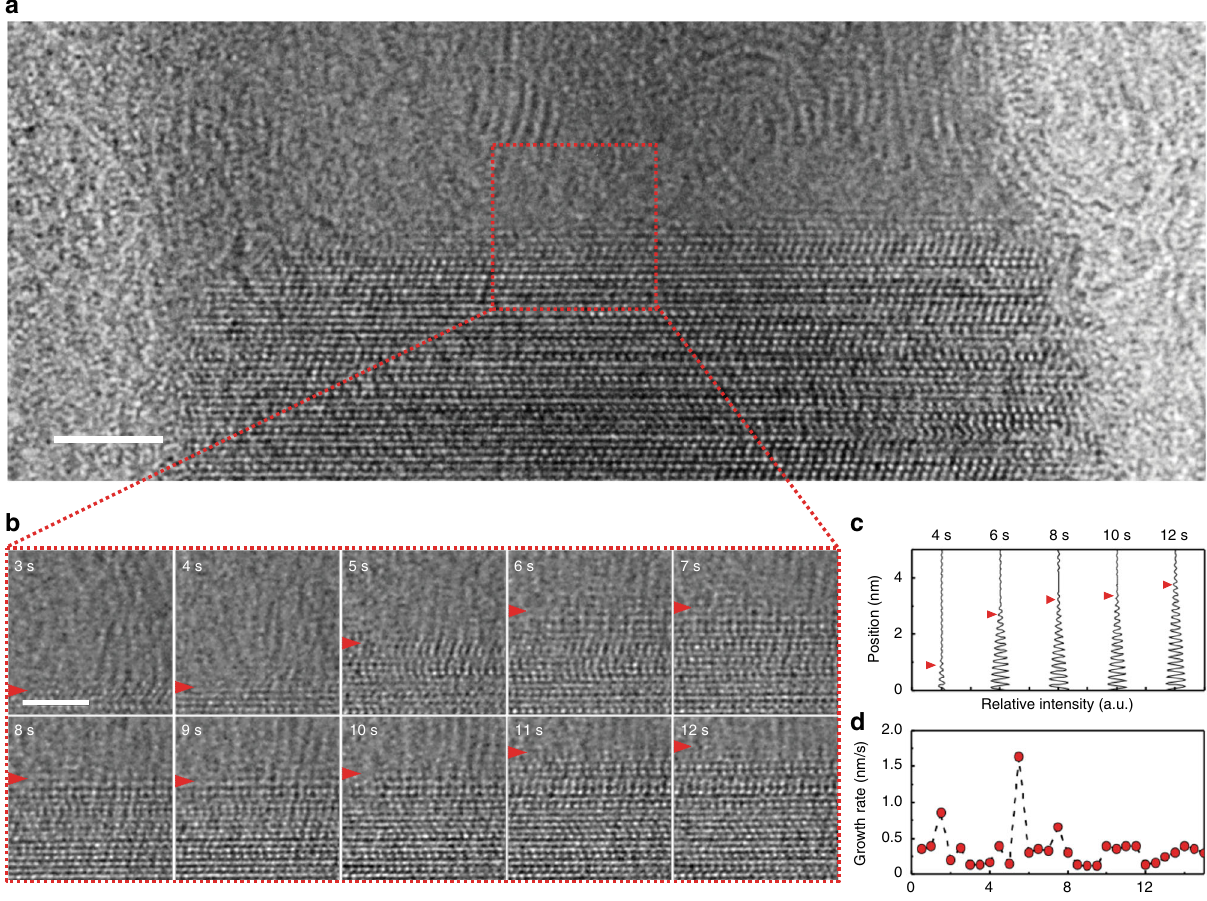
Fig. 2 Growth rates of a 23 nm-diameter MG nanorod heated at 360 °C. a A TEM image from an in situ TEM movie (Supplementary Movie 3) of a 23 nm MG nanorod upon rapid heating from the glass (30 °C) to the crystallization temperature (360 °C). The boundary between the crystalline and amorphous region marks the growth front. b Snapshots with 1 s time intervals. The growth front (marked by the red arrow) progresses stochastically in time. c Intensity pro fi les from the fi ltered TEM images with red arrows that mark the position of the growth front. The growth front was marked at 10% of the maximum intensity value, allowing us to quantitatively measure the growth rate as a function of time. d Growth rate versus time for the 23 nm MG rod. Note that the growth rate fl uctuates in time. All scale bars are 2 nm. The in situ movie was taken at the acquisition rate of 400 frames per second. The TEM images were obtained by averaging 200 consecutive frames of the TEM movie for increased signal-to-noise